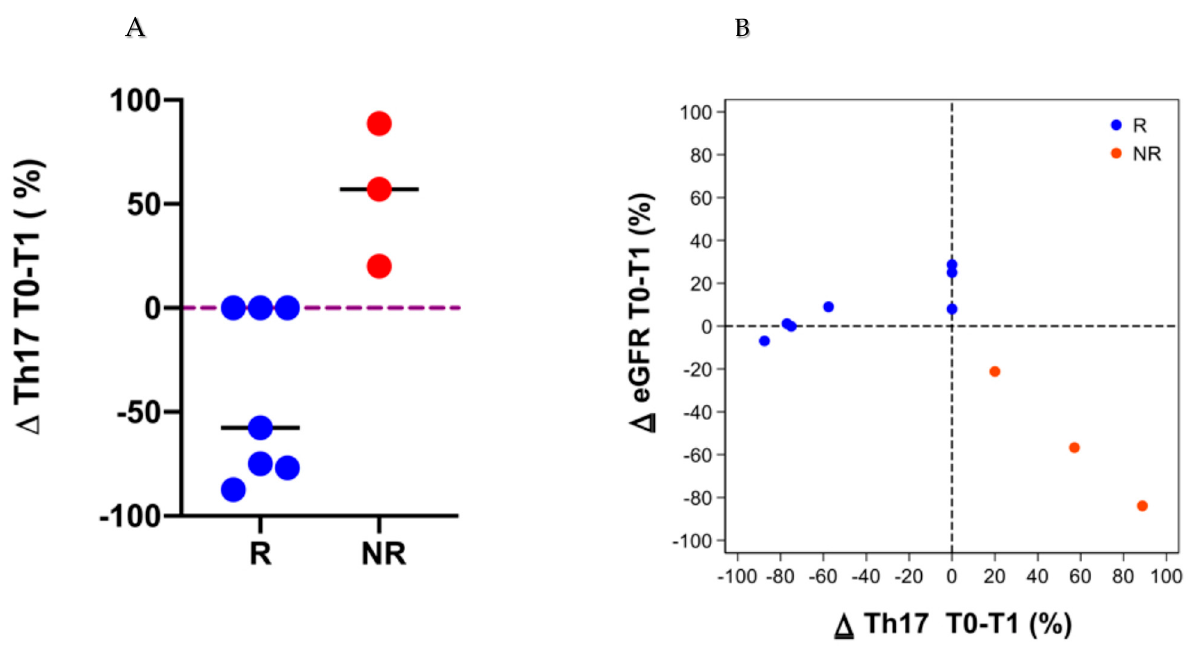
Figure 7. Th17 cells were analyzed in all of the patients except in one responder (R) patient and the dropout patients. Panel ( A ): The data are expressed as Δ percentage of the Th17 cells’ number before (T0) and after 1 year (T1) of ECP treatment. The blue dots represent R patients and the red dots represent the non-responder (NR) patients; the line represents the median. Panel ( B ): A scatter plot illustrating the relationship between the Δ percentage of the Th17 cells and Δ eGFR in the R and NR patients. The blue dots and red dots represent R and NR patients, respectively. The diagram shows an inverse correlation between the Δ percentage of Th17 cells and the Δ eGFR in NR patients.